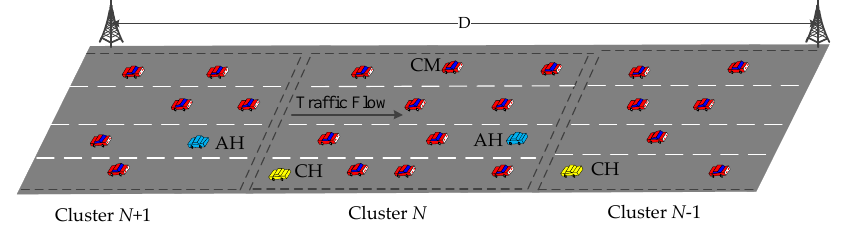
Figure 20. Clustering structure of CADMA.